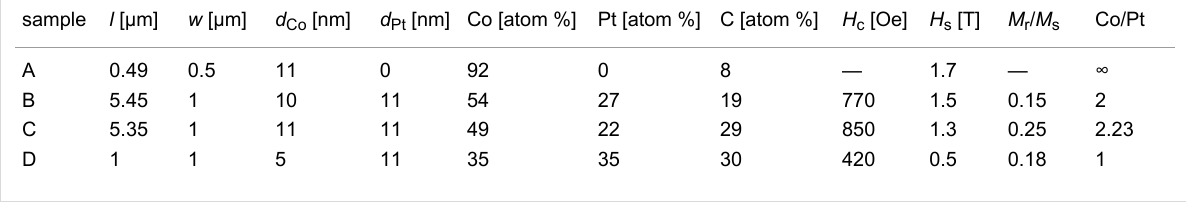
Table 1: Geometrical dimensions, thickness-integrated composition, and magnetic properties of the samples. l : length; w : width; d Co : thickness of the Co layer; d Pt : thickness of the Pt layer; H c : coercive field; H s : saturation field; M r / M s : remanent-to-saturation magnetization ratio (squareness). sample l [ μ